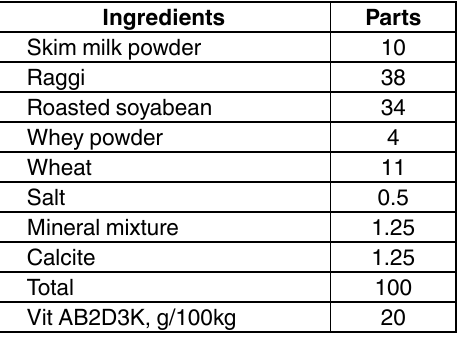
table 2. Ingredient composition of milk replacer offered to calves ingredients